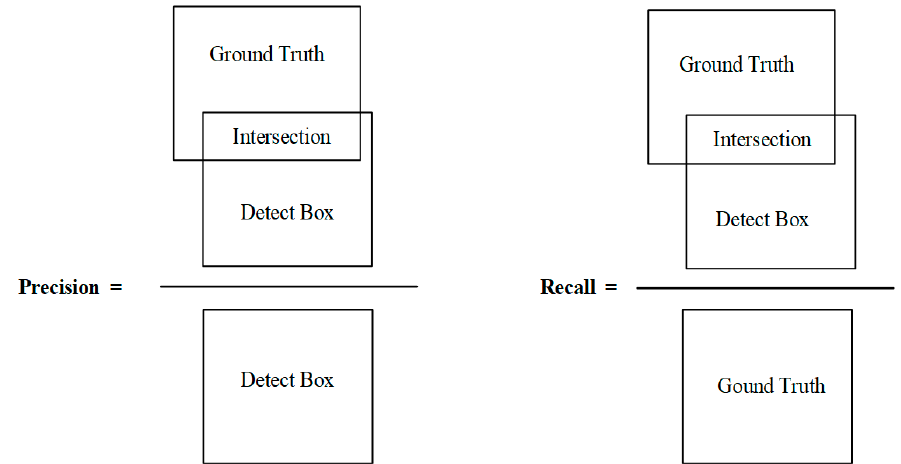
Figure 10. Calculation of PRE and RECALL in the object detection algorithm.